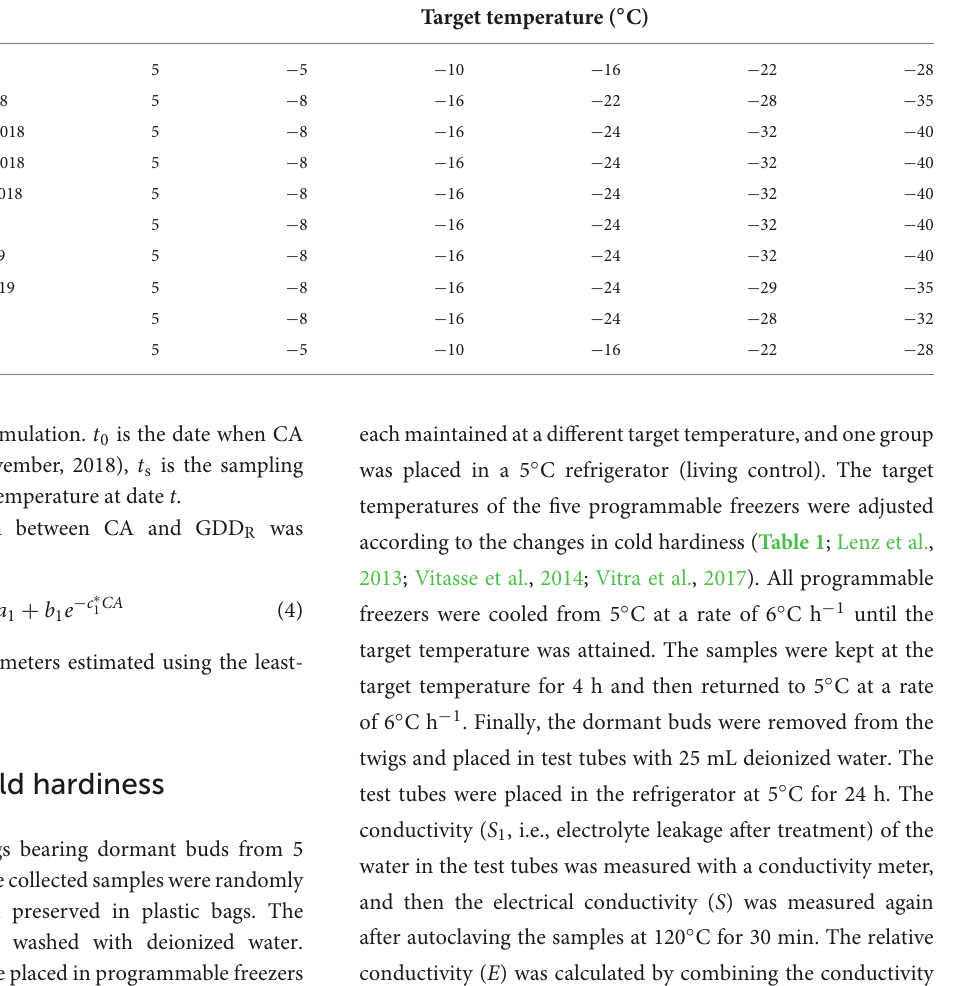
TABLE 1 Target temperatures of each treatment at different sampling